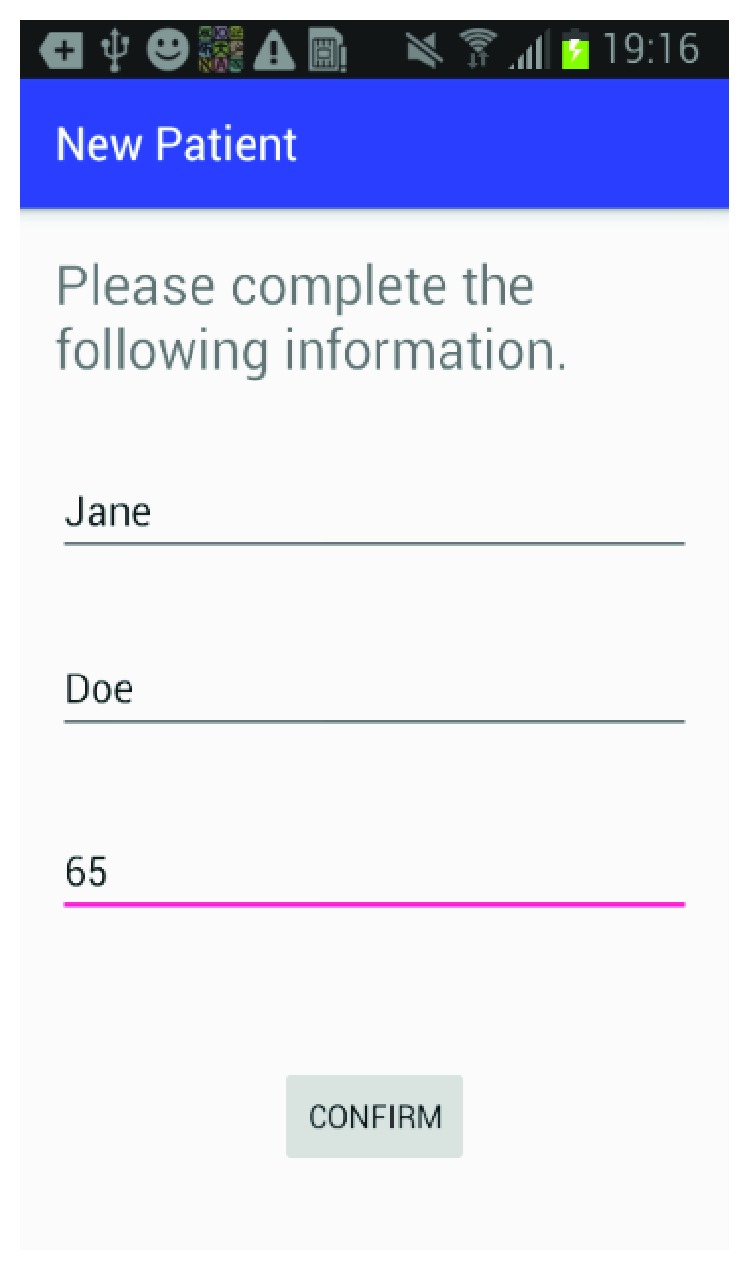
Patient information.